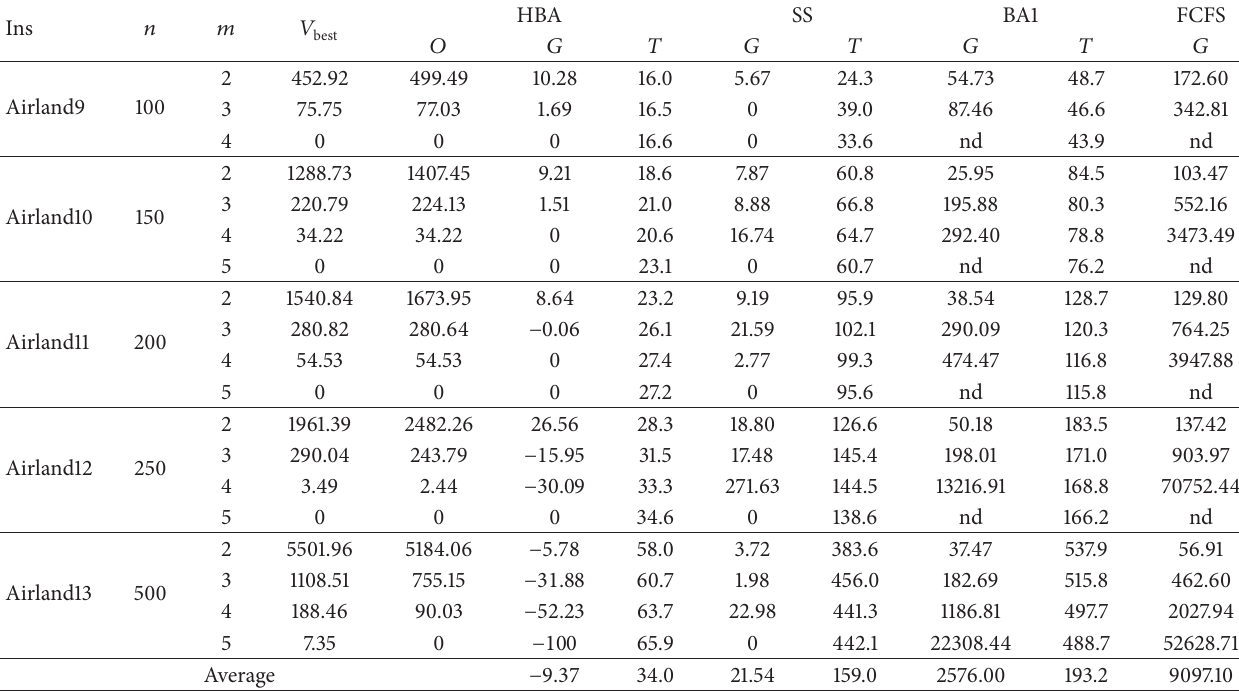
Table 2: The comparisons of computational results for second group